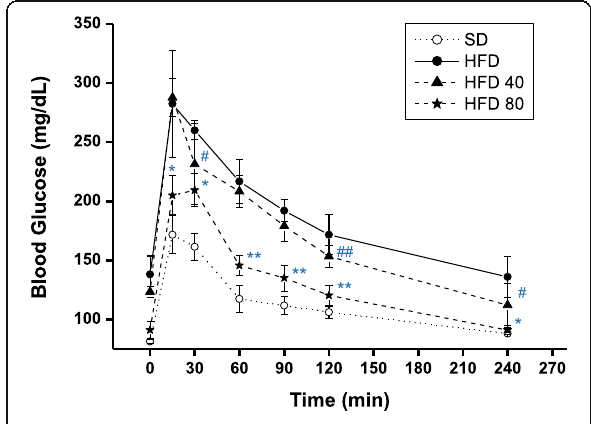
Fig. 9 Effect of purpurin on glucose tolerance in high-fat diet fed mice. # p < 0.5, ## p < 0.01 on means of HFD 40 versus high-fat diet. * p < 0.5, ** p < 0.01 on means of HFD 80 versus high-fat